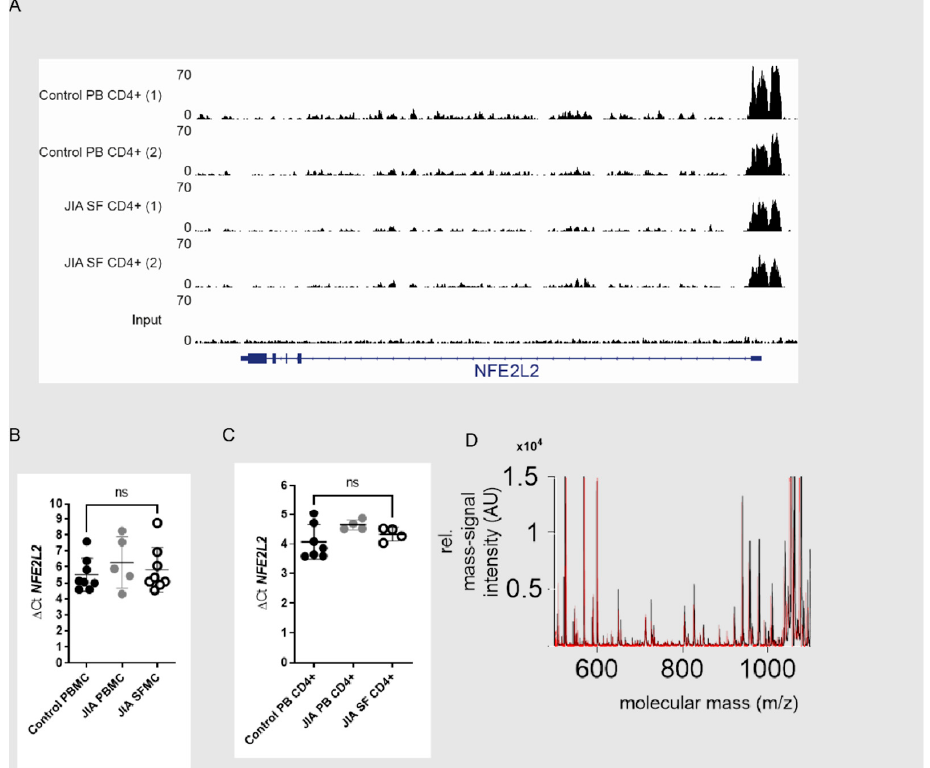
Figure 3. NRF2 is not regulated by transcriptional mechanism and shows no posttranscriptional protein modifications. ( A ) H3K27Ac ChIP-seq tracks at the SLC27A2 loci in T cells from peripheral blood(PB) and synovial fluid (SF). Δ Ct is calculated as (Ct (NFE2L2)-Ct (ACTB (housekeeping gene). ( B ) Δ Ct of NFE2L2 mRNA expression in HC PBMCs (N = 8 for donors), JIA PBMCs (N = 5 for donors) and JIA SFMCs (N = 8 for donors), an ordinary one-way ANOVA Dunnett’s multiple comparison test was performed. ( C ) Δ Ct of NFE2L2 mRNA expression in CD4 + T cells from HC peripheral blood (N = 7 for donors and 4 individual experiments), JIA peripheral blood (N = 4 for donors and individual experiments) and synovial fluid from JIA patients (N = 4 for donors and individual experiments), an ordinary one-way ANOVA Dunnett’s multiple comparison test was performed. ( D ) HC CD4 + T cells were incubated with either 10% HC (N = 5 for donors and two individual experiments) serum or SF (N = 6 for donors and 2 individual experiments) for 18 h for Mass Spectrometric analysis.